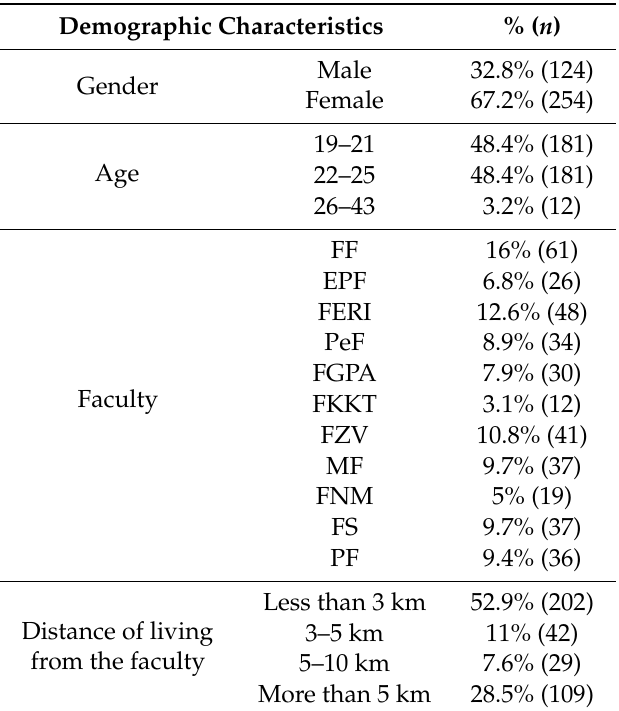
Table 1. Demographic characteristics of the